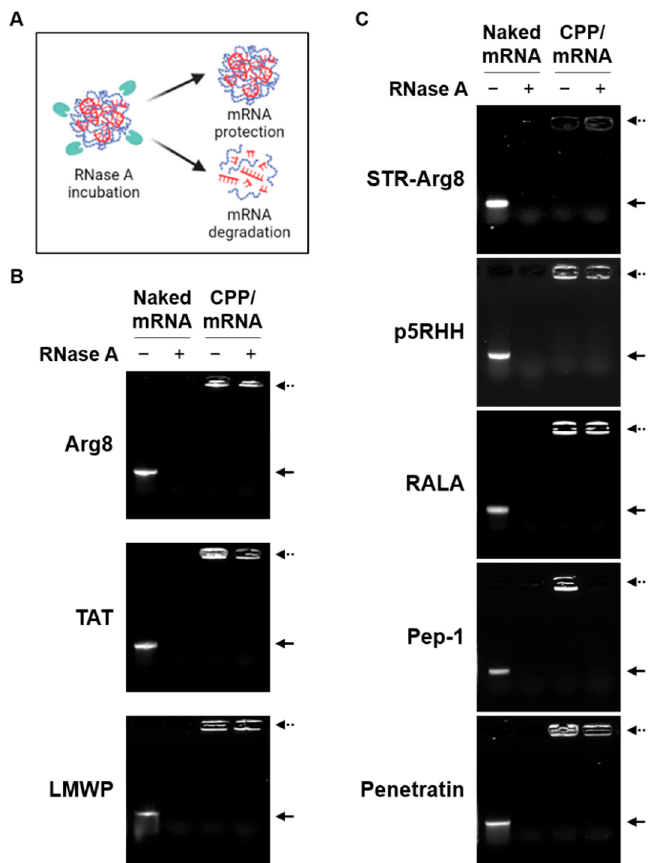
Figure 3. The protective ability of CPP/mRNA complexes. ( A ) Schematic showing the protective ability of the CPP/mRNA complexes from RNase. Representative agarose gel images showing naked mRNA and cationic ( B ) or amphipathic ( C ) CPP/mRNA complexes (with or without RNase A incubation). Solid arrow represents naked mCherry mRNA and dashed arrow represents CPP/mCherry mRNA complexes.